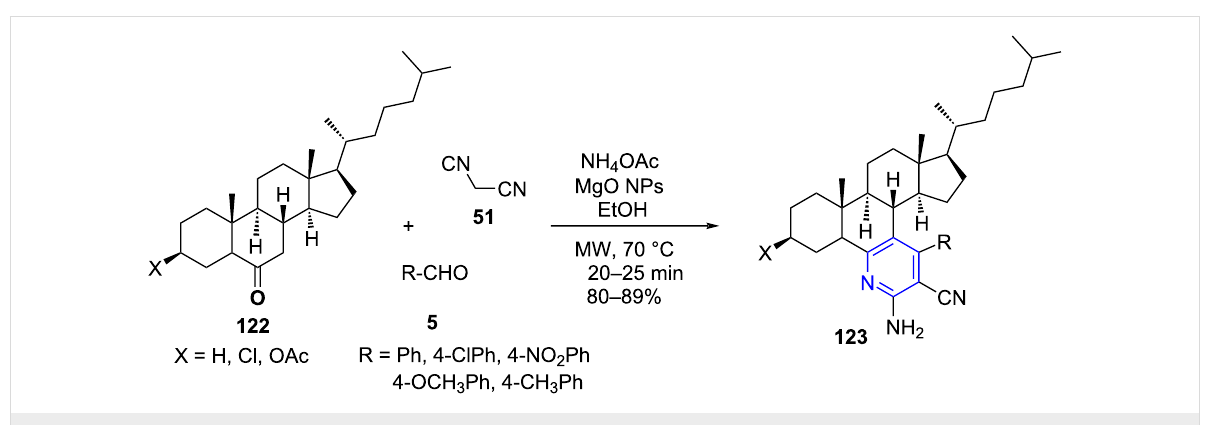
Scheme 45: Synthesis of steroidal